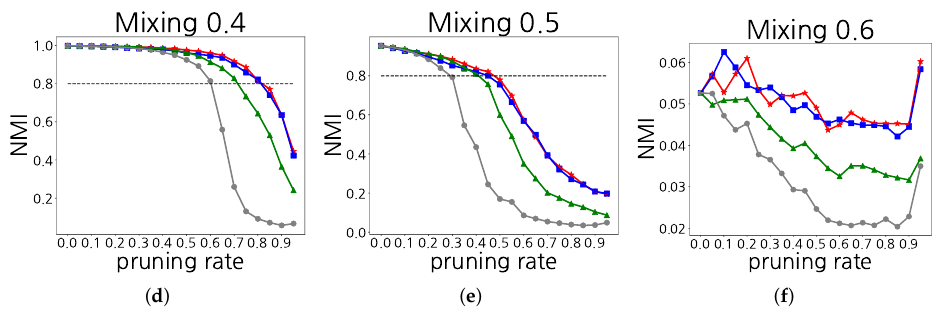
Figure 4. NMI values when varying α : ( a ) mixing 0.1; ( b ) mixing 0.2; ( c ) mixing 0.3; ( d ) mixing 0.4; ( e ) mixing 0.5; and ( f ) mixing 0.6.